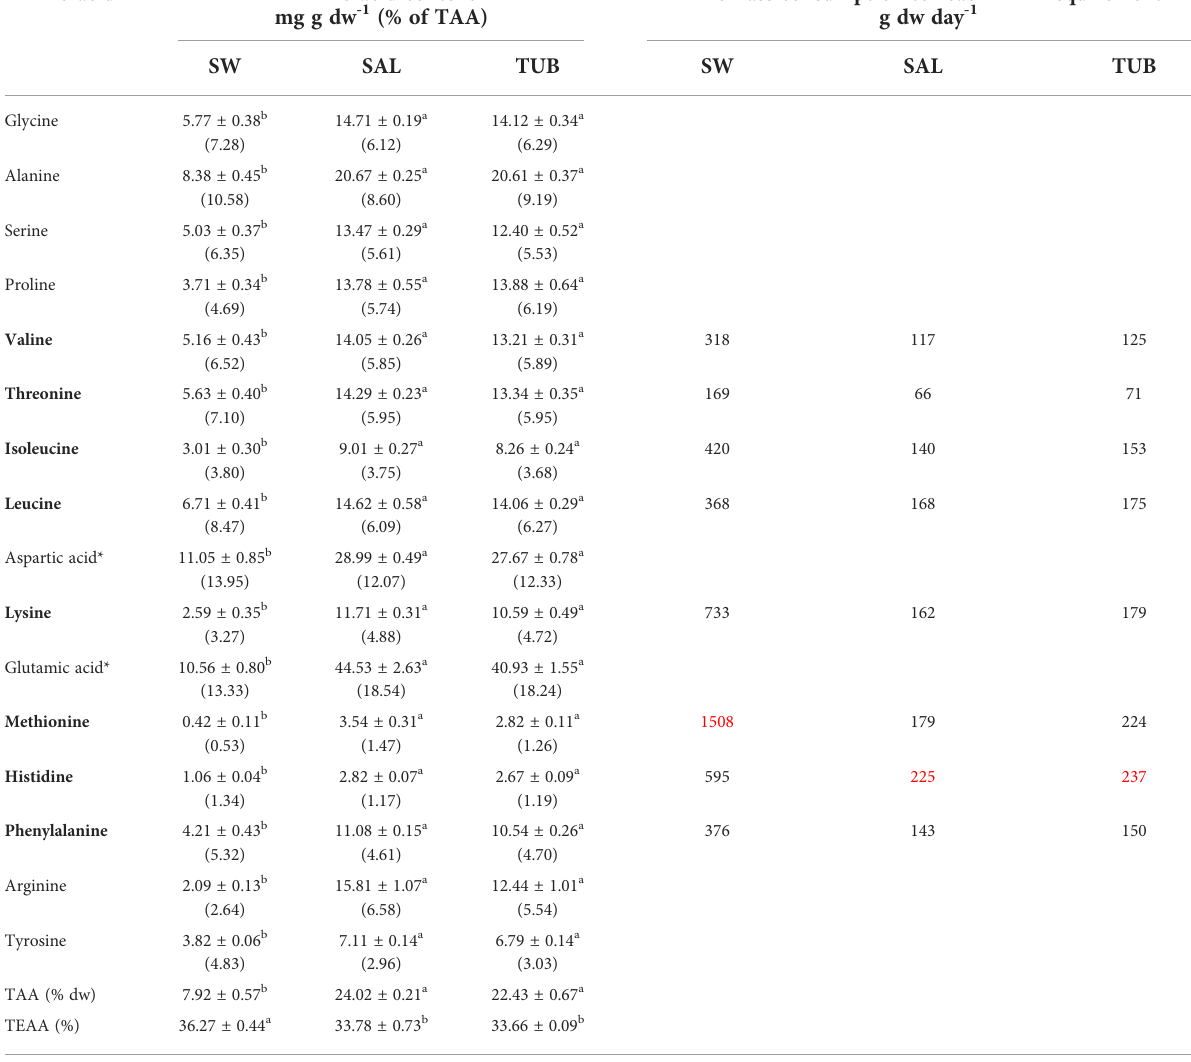
TABLE 5 Amino acid composition (mg g dw -1 ) of dried biomass of Ulva fenestrata cultivated in seawater control (SW) and the two herring production process waters salt brine (SAL) and tub water (TUB) (mean ± SEM, n = 3) after 14 days, as well as the biomass (g dw day -1 ) consumption needed to reach the recommended daily intake of essential amino acids (EAA) (Eq. 2, based on a body weight of 63.3 kg) as provided by the World Health Organization (WHO/FAO/UNU, 2007). Amino